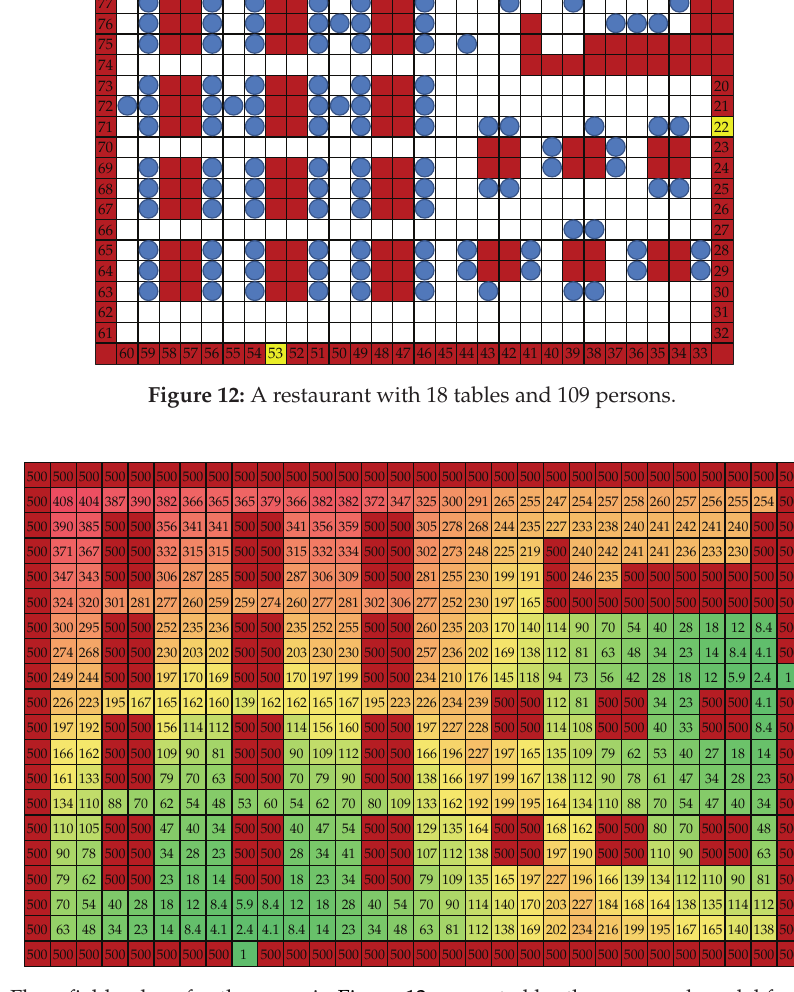
Figure 13: Floor-field values for the room in Figure 12 generated by the proposed model for the first time